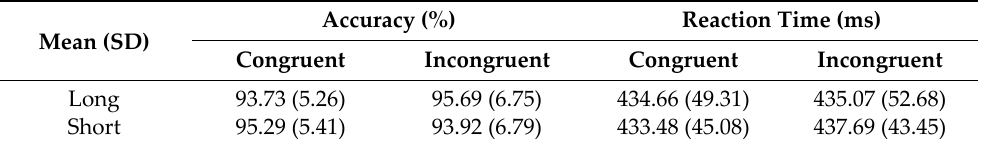
Table 1. Behavioural results in the lexical decision